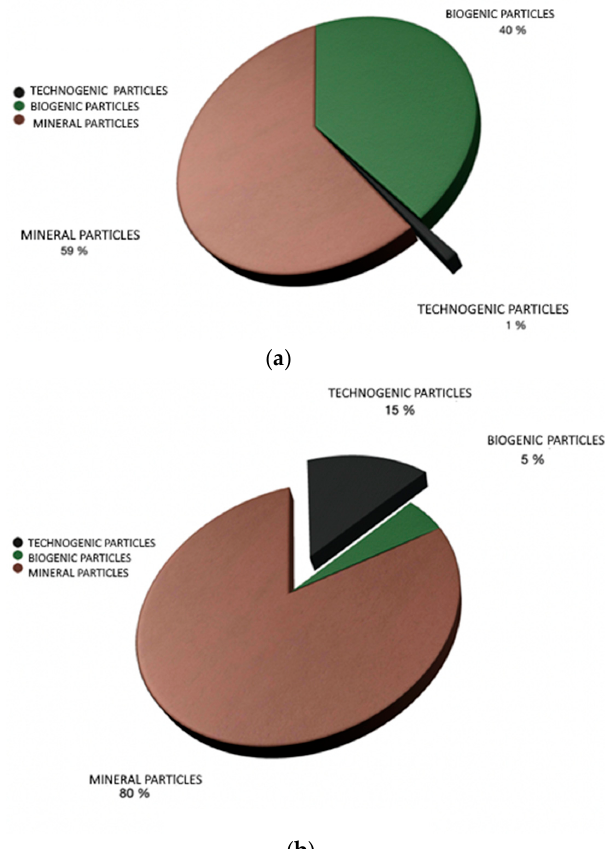
Figure 8. The proportion of particles of different genesis in the sample from the roof ( a ) and road dust ( b ). dust ( b